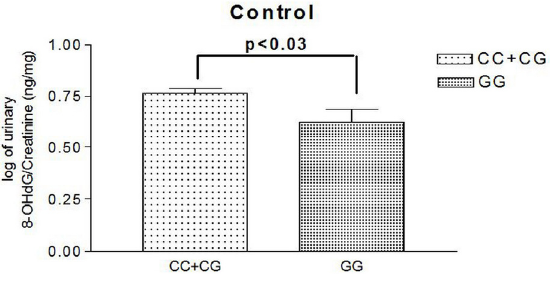
Figure 1. Urine 8-OHdG concentrations in different genetic variants. CC, Ser/Ser; CG, Ser/Cys; GG, Cys/Cys.